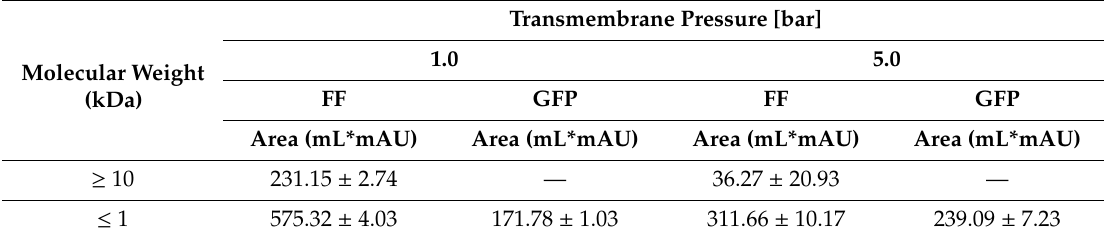
Table 8. FPLC chromatogram areas of the peaks from the retentates and permeates of pre-treated